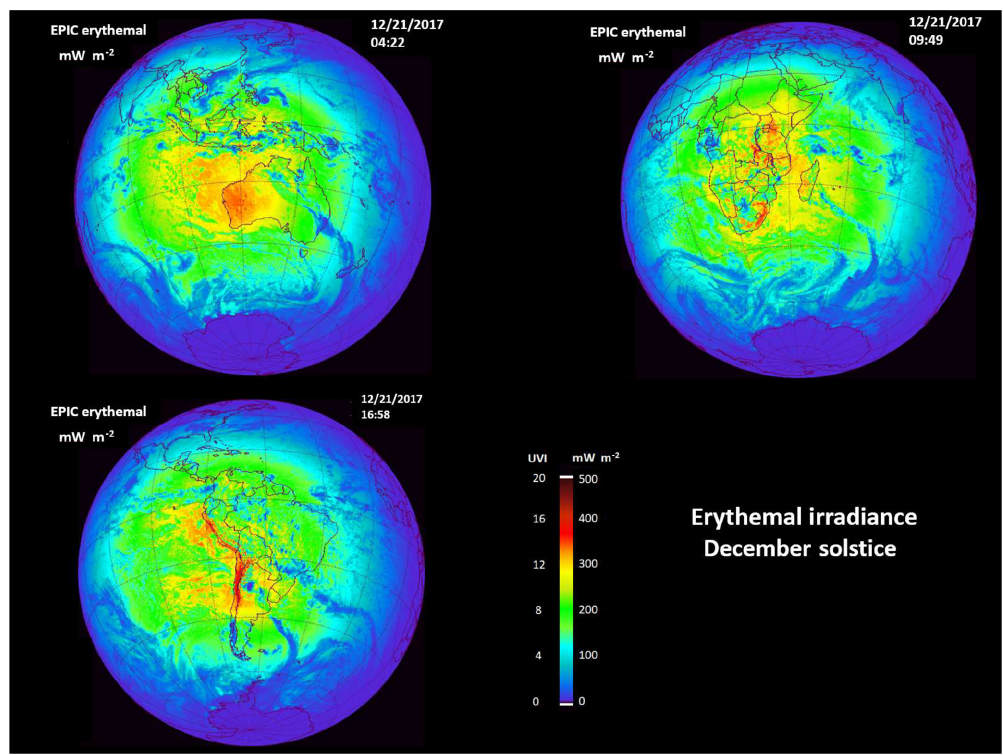
Figure 13. E(ζ,ϕ,t O ) and UVI( ζ,ϕ,t O ) from sunrise to sunset for the 21 December 2017 solstice. The three images are for different GMT. Figure map created with IDL ® .